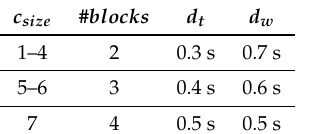
Table 2. Feasible configurations.